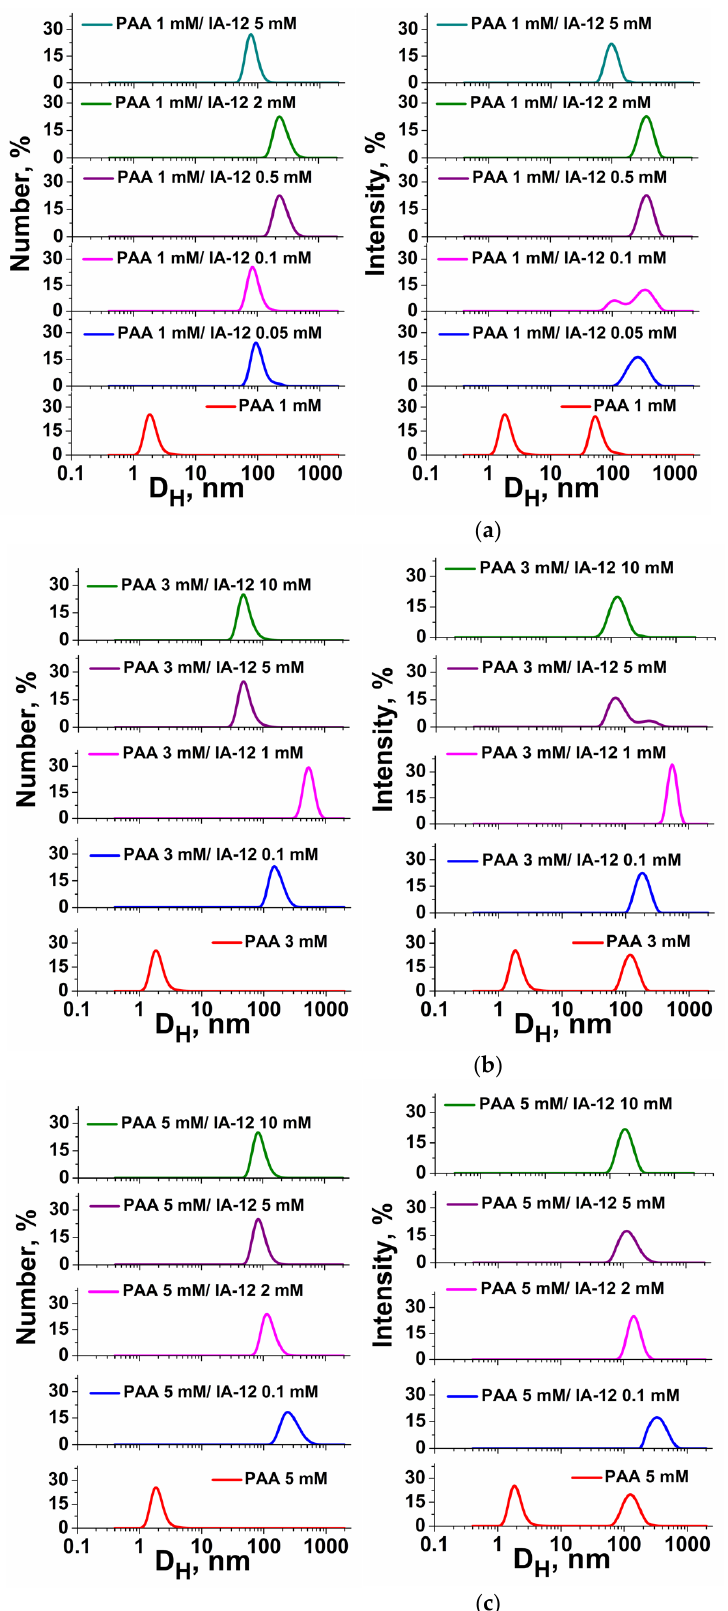
Figure 3. Number- and intensity-averaged size distribution for the IA-12/PAA binary systems at various fixed PAA concentrations: ( a ) 1 mM; ( b ) 3 mM; ( c ) 5 mM; 25 ◦